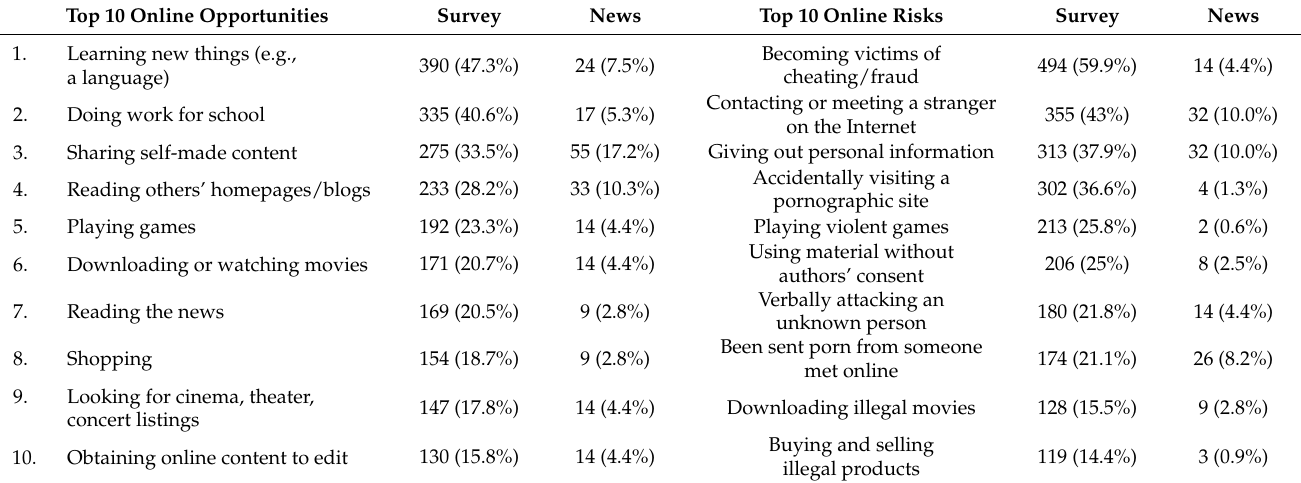
Table 1. Adolescents’ online risks and opportunity activities mentioned by survey respondents and their corresponding salience in news